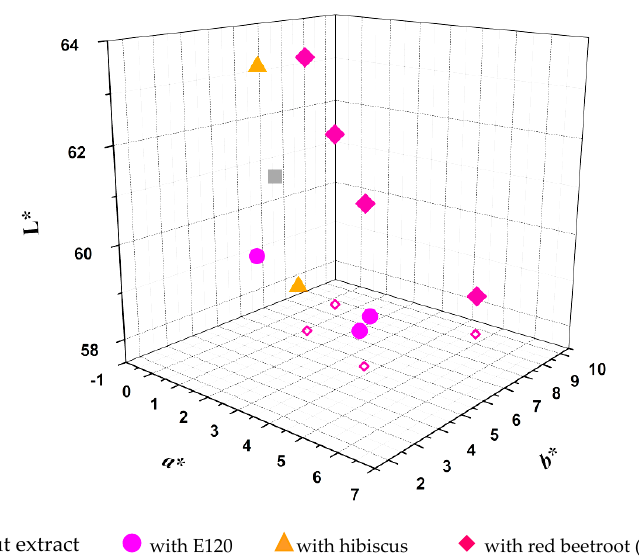
Figure 7. Representation of the colors of the several samples in the L*a*b* color scheme.